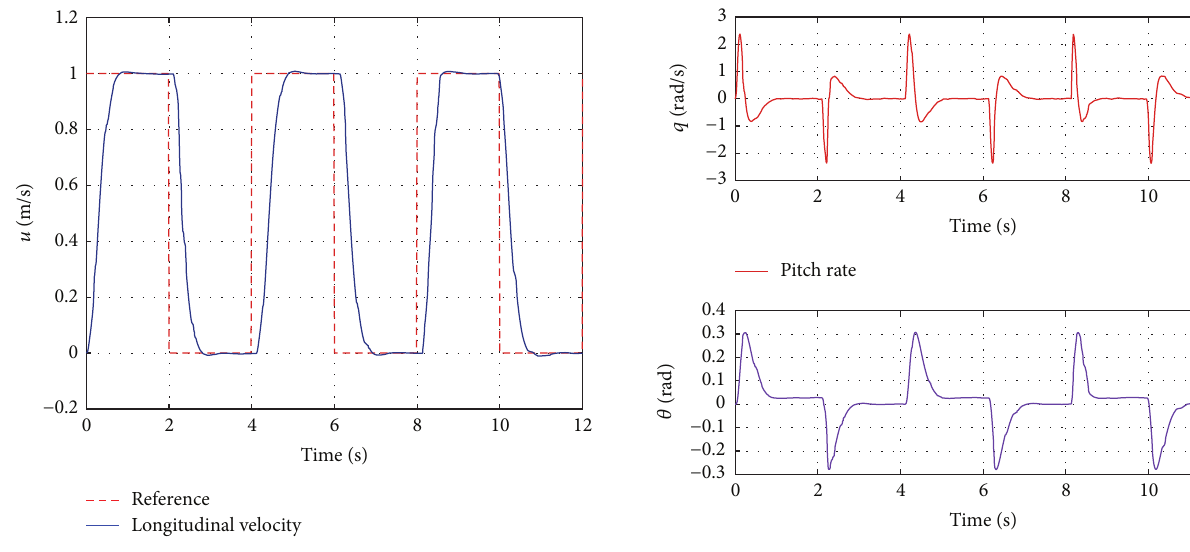
Figure 6: The performance of speed tracking in longitudinal channel.